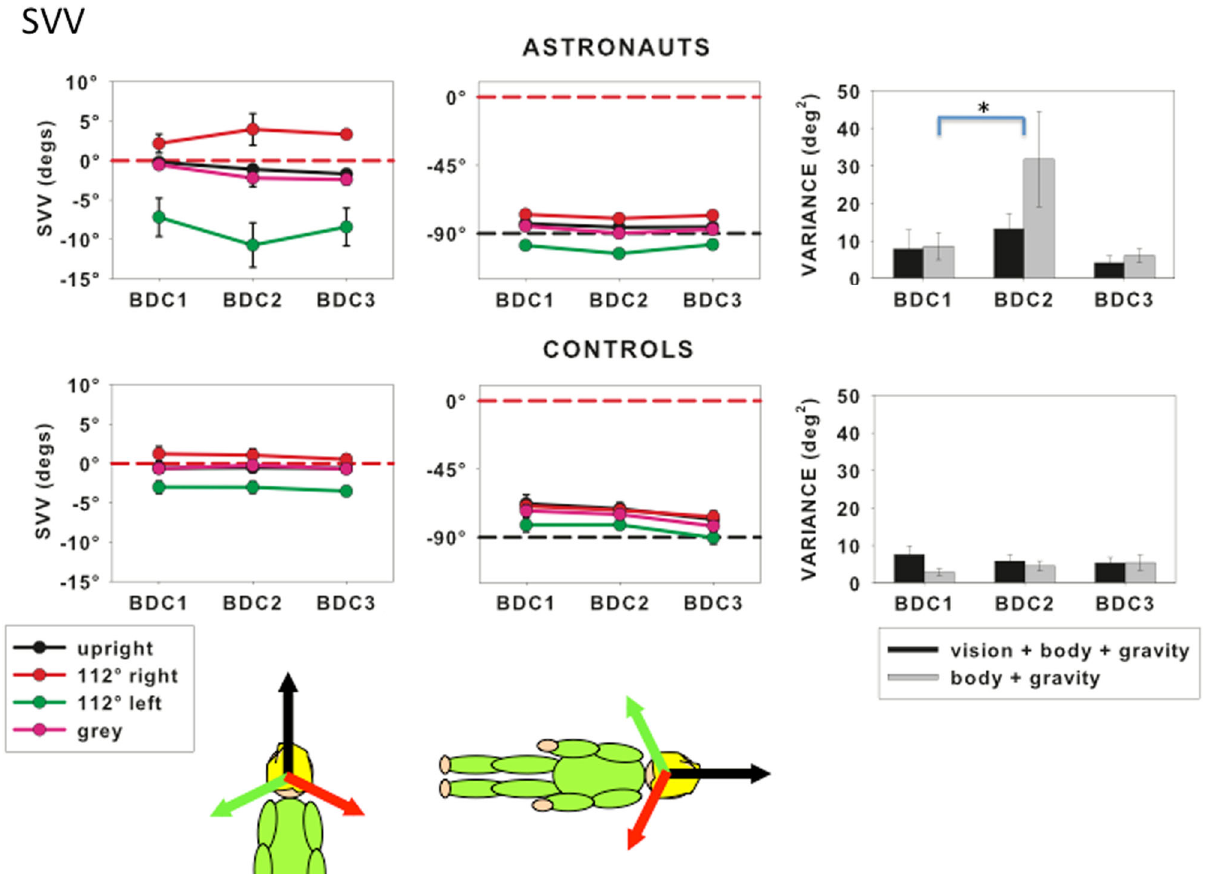
Fig. 1 The SVV for astronauts ( top row ) and control participants ( bottom row ) for BDC1 (before fl ight), BDC2 and BDC3 (after fl ight). 0° corresponds to the top of the head ( red dashed lines ), negative values indicate tilt to the left . Means and standard errors across participants are shown for the SVV measured in the presence of four visual backgrounds: upright ( black lines and symbols ), tilted to right ( red lines and symbols ), tilted to left ( green lines and symbols ), and gray ( purple lines and symbols ). Inserts show the direction of the visual cues relative to the body. The histograms show variances in deg 2 for the upright SVV with ( black bars ) and without ( gray bars ) visual cues to upright. Asterisks indicate that variances for BDC1 were signi fi cantly lower than for BDC2 when only body and gravity cues contributed npj Microgravity (2017)